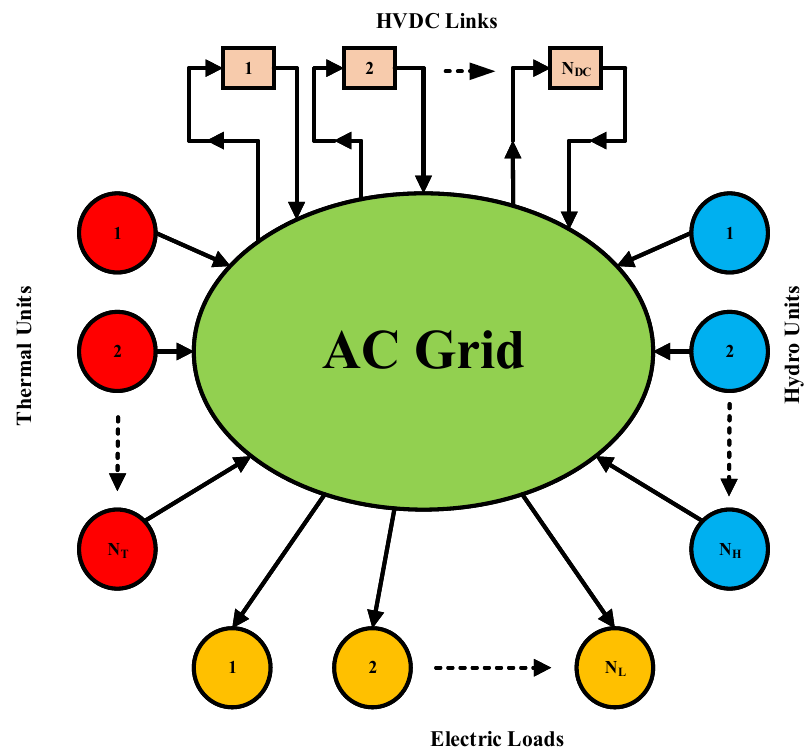
Figure 1. Generalized network